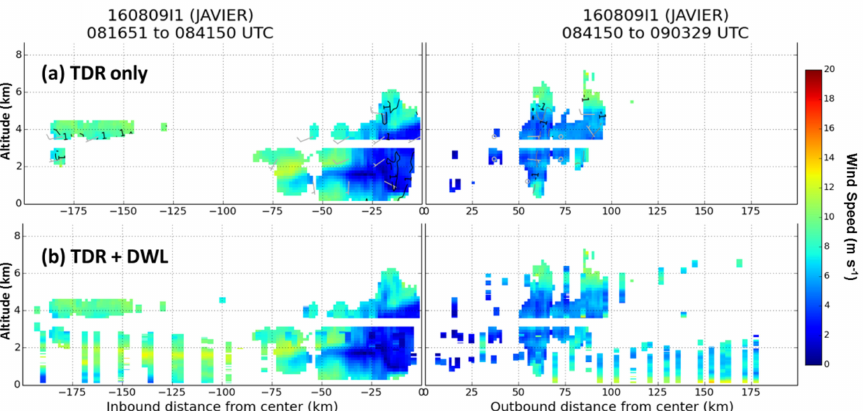
Figure 8. Comparison of a cross section through the center of Tropical Storm Javier on 0840 UTC 9 August 2016 with wind speeds (m s − 1 , shaded) collected by ( a ) the TDR only and ( b ) the TDR and the ADWL.